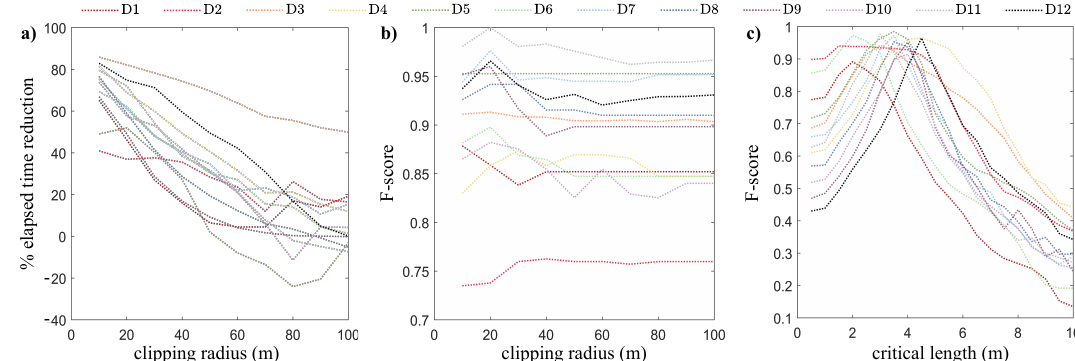
Figure 9. ( a ) Percentage reduction of the elapsed time for different clipping radii with respect to the case of infinite clipping radius. F-score for different values of the clipping radius parameter ( b ), and the critical length parameter ( c